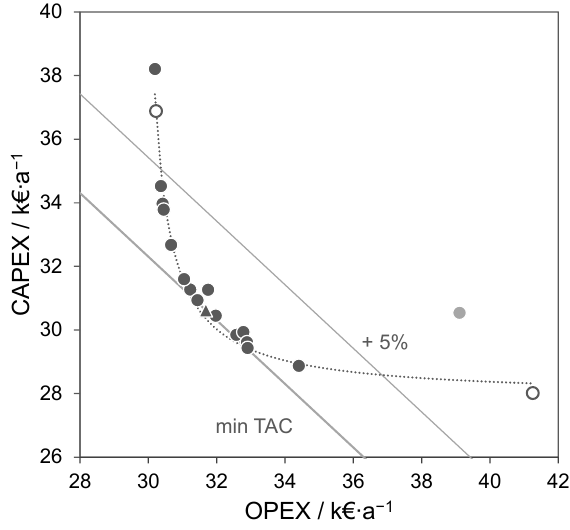
Figure 6. Set of solutions close to Pareto-optimality for the heteroazeotropic distillation of ethanol and water using cyclohexane as solvent. The white circles indicate the individual optimization of the OPEX and CAPEX, respectively, and the thick and thin lines are lines of constant TAC for the lowest costs and an additional 5%. The light-gray circle denotes a locally optimized but finally sub-optimal solution, which is not in close vicinity to the approximated Pareto front and omitted for the fit of Equation (2) shown as dotted